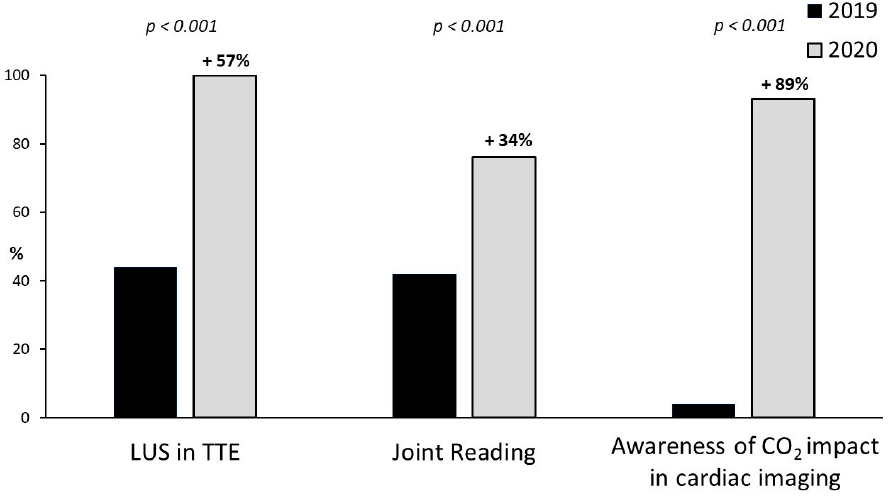
Figure 2. Percentage difference from November 2019 (black bar) to November 2020 (gray bars) in lung ultrasound evaluation in resting TTE, joint reading assessment with intensivists and awareness of carbon dioxide (CO 2 ) impact in cardiac imaging.